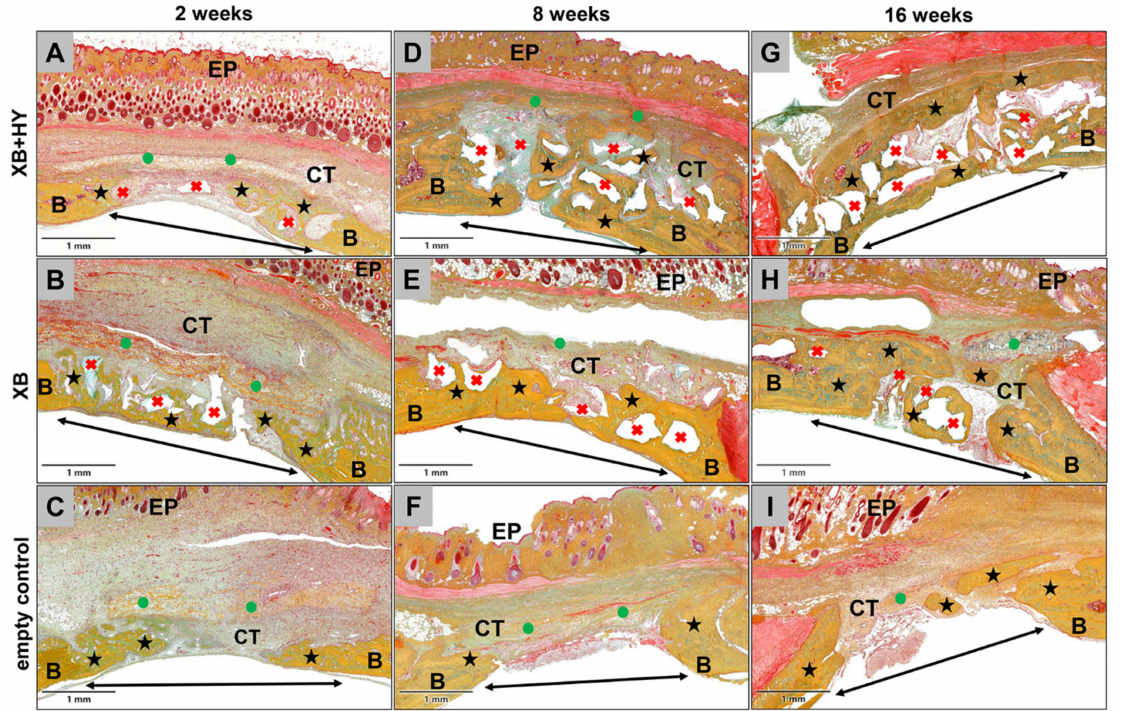
Figure 1. Representative overview of the bone healing process in the different study groups at 2 weeks ( A–C ), 8 weeks ( D–F ), and 16 weeks ( G–I ) post implantationem. Double arrow = bony implantation site, B = local bone, black asterisks = newly formed bone, red crosses = granules of the xenogeneic BSM, green circles = remnants of the collagen membrane, CT = connective tissue, EP = epidermis (Movat’s Pentachrome stainings, 100 × magnifications, scalebars = 1